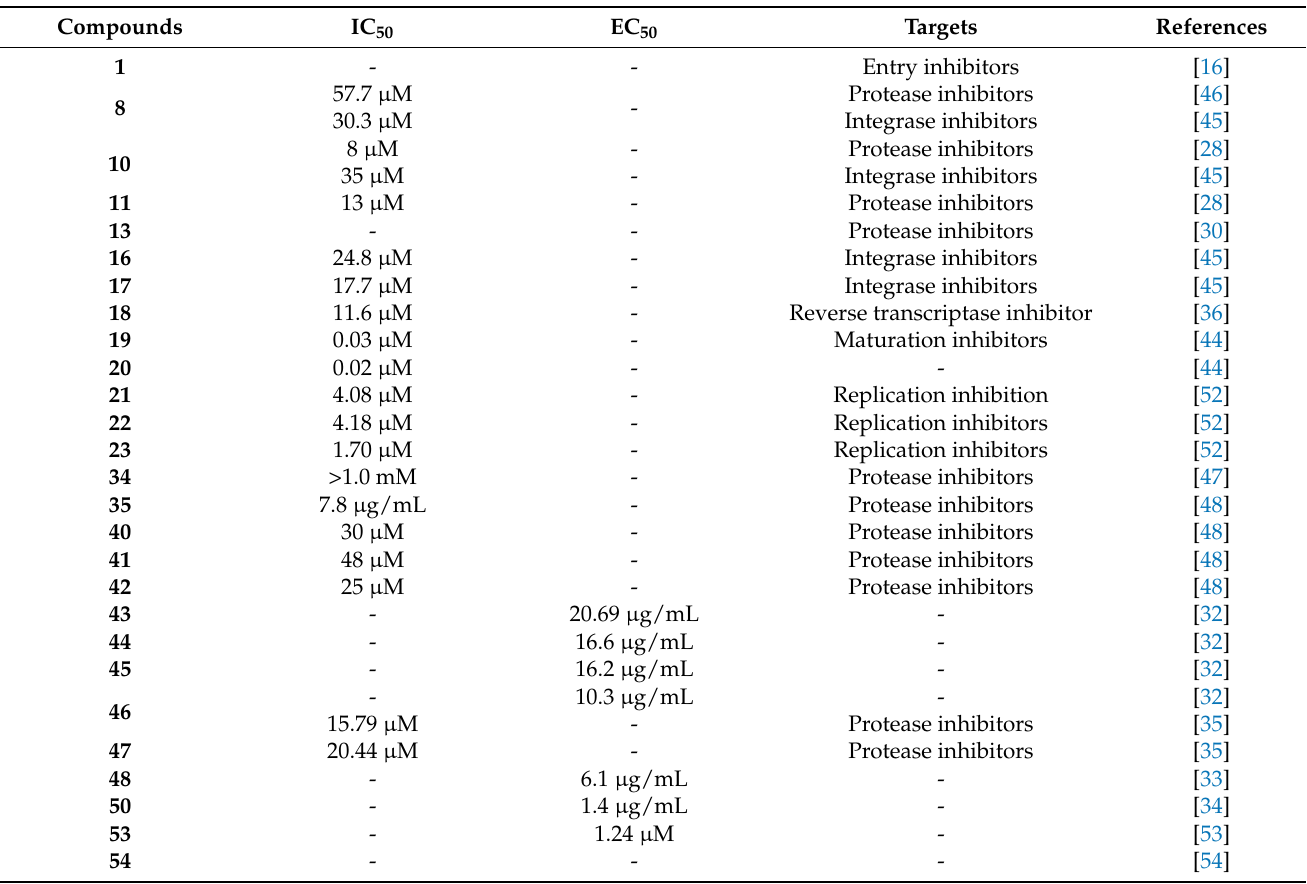
Table 1. Summary of anti-HIV triterpenoids and their targets and